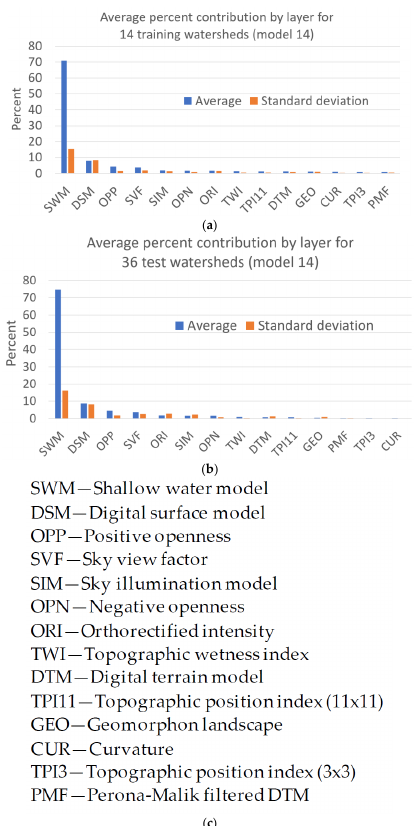
Figure 15. Average percent contribution of each input layer for U-net model 14 that uses 14 watersheds for training. Contribution for a layer is estimated from the average change in 10 model mean squared error values (MSE) from the original model MSE based on 10 separate randomizations of an input layer. Average contributions for input layers in (a) the 14 training watersheds, and (b) the 36 test watersheds, with layer names shown in (c).